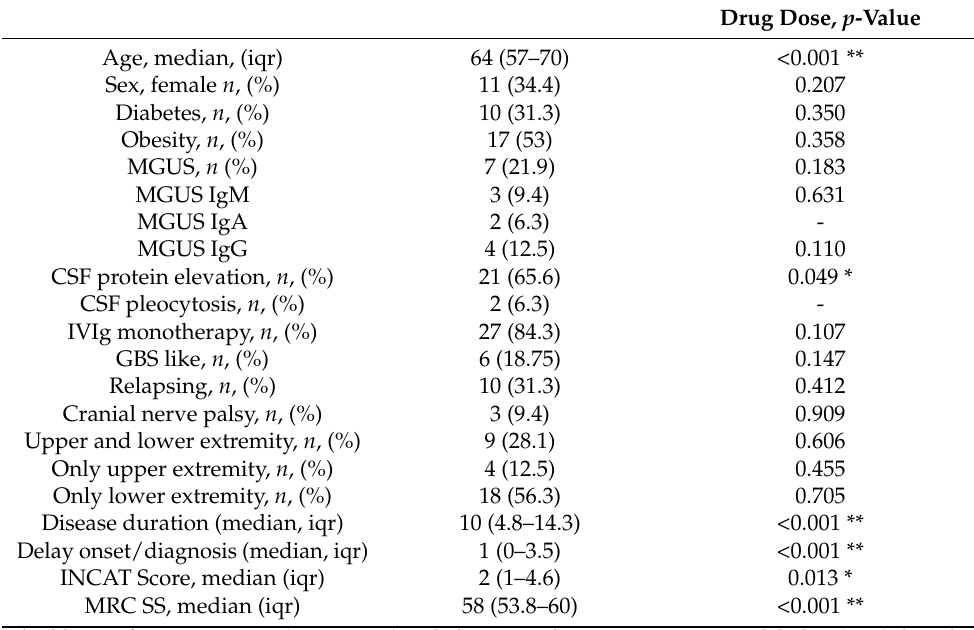
Figure 2. Individual patients’ characteristics. An overview of the characteristics of the CIDP patients is presented. Abbreviations: MGUS monoclonal gammopathy of undetermined significance, GBS Guillain–Barre Syndrome, CSF Cerebrospinal fluid. Table 1. Patients’ characteristics and association with drug